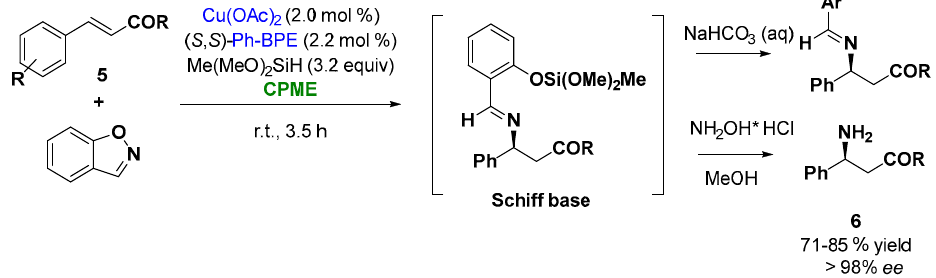
Figure 6. Enantioselective Cu-catalyzed hydroamination of cinnamoyl derivatives.